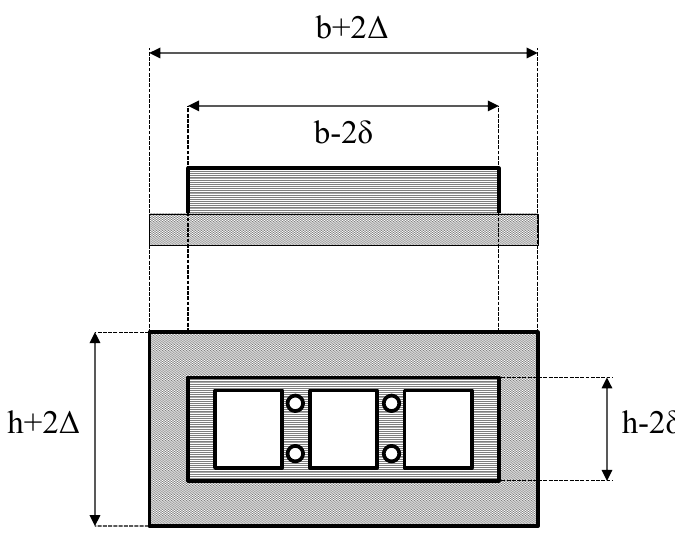
Figure 2. Schematic drawing of the front mask.